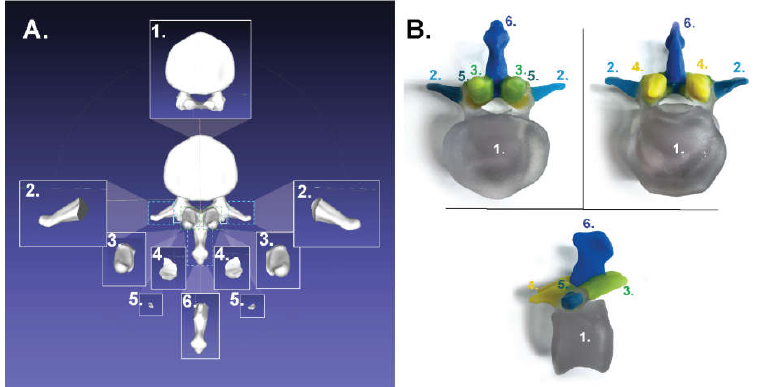
Figure 2. Panel A: STL source and split files for the femur (inferior view). Panel B: Poly‐jet prints with multiple colors. Top right shows the superior view, top left shows the inferior view, and bottom shows the sagittal view. Features include 1. body, 2. transverse processes, 3. inferior articular facet, 4. superior articular facet, 5. accessory process, and 6. spinous process.